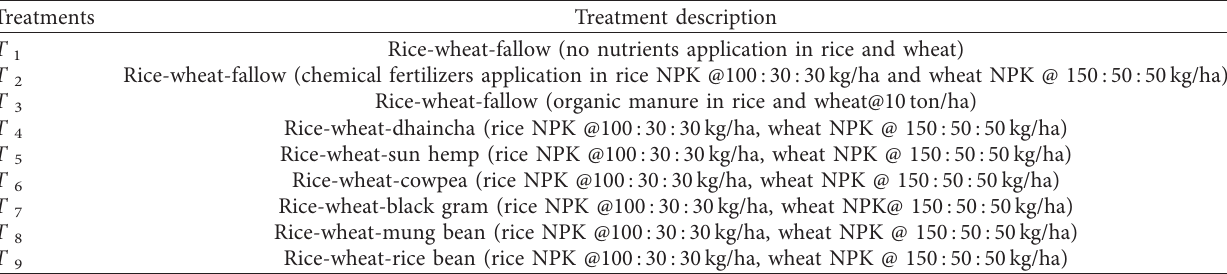
Table 1: Treatments details.